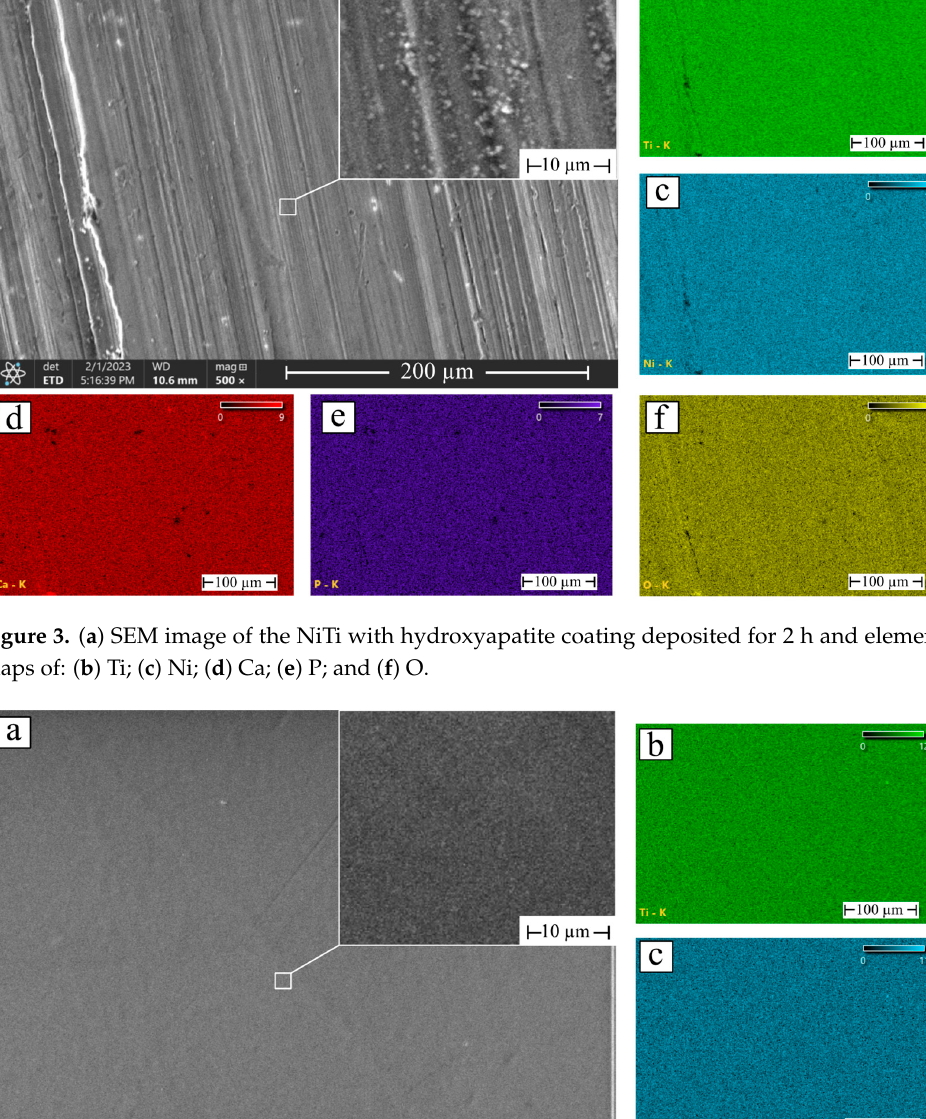
Figure 2. ( a ) SEM image of the NiTi with hydroxyapatite coating deposited for 1 h and elemental